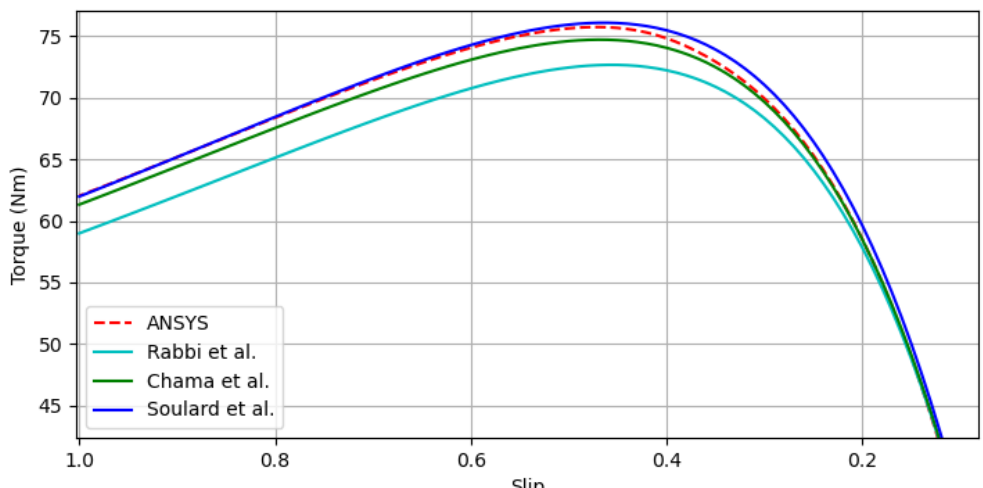
Figure 8. Various (Rabbi et al. [8], Chama et al. [9], Soulard et al. [19]) analytical cage torque curves for the Radial 1 design.